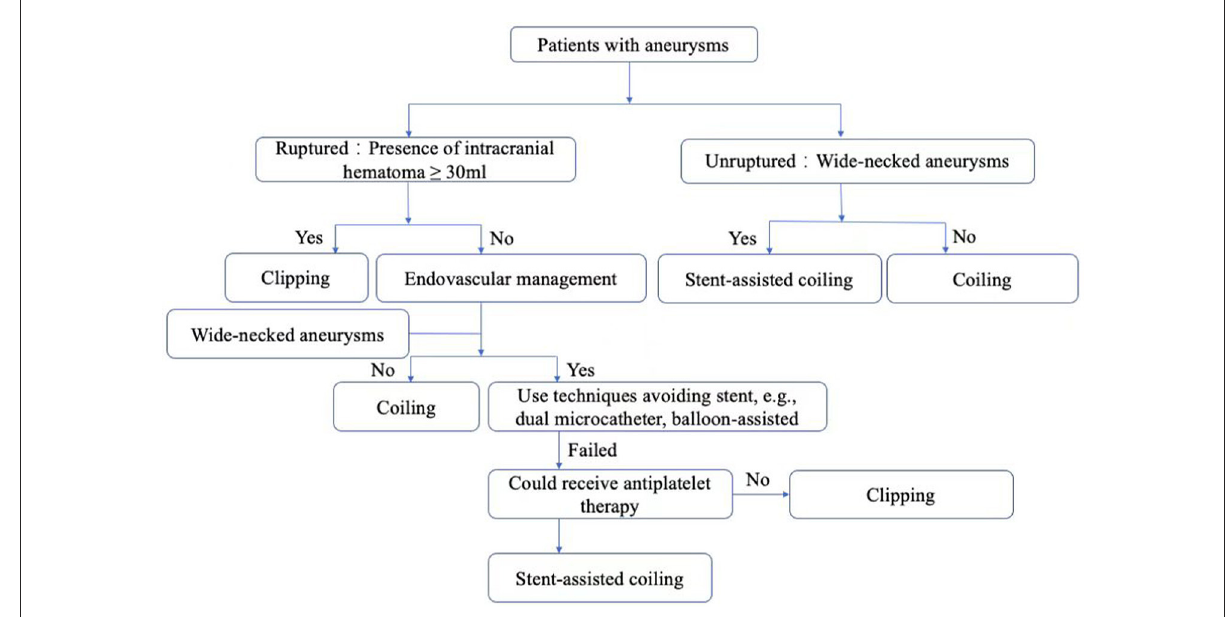
FIGURE1 Decision-making chart for treatment options for patients with